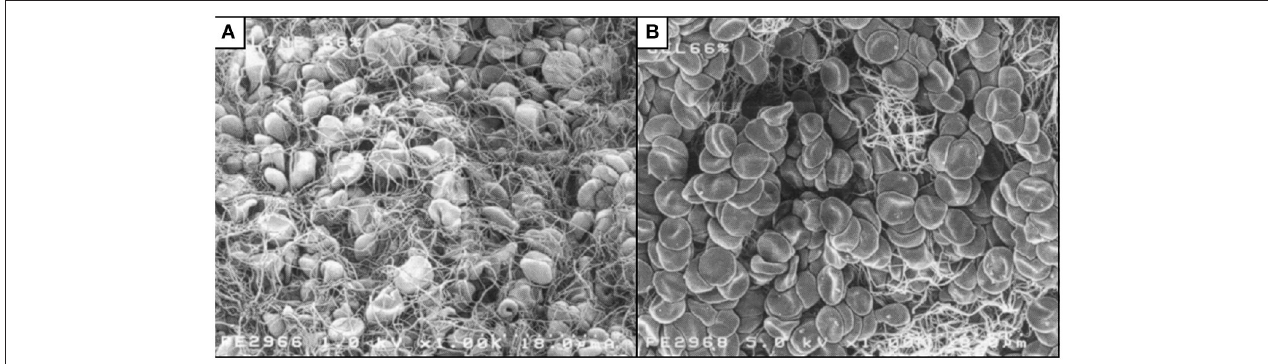
FIGURE 1 | Scanning electron micrographs of whole blood diluted to 66% with 0.9% saline (A) or succinylated gelatin (B) . Less fibrin meshwork is visible with gelatin dilution. Reproduced with permission